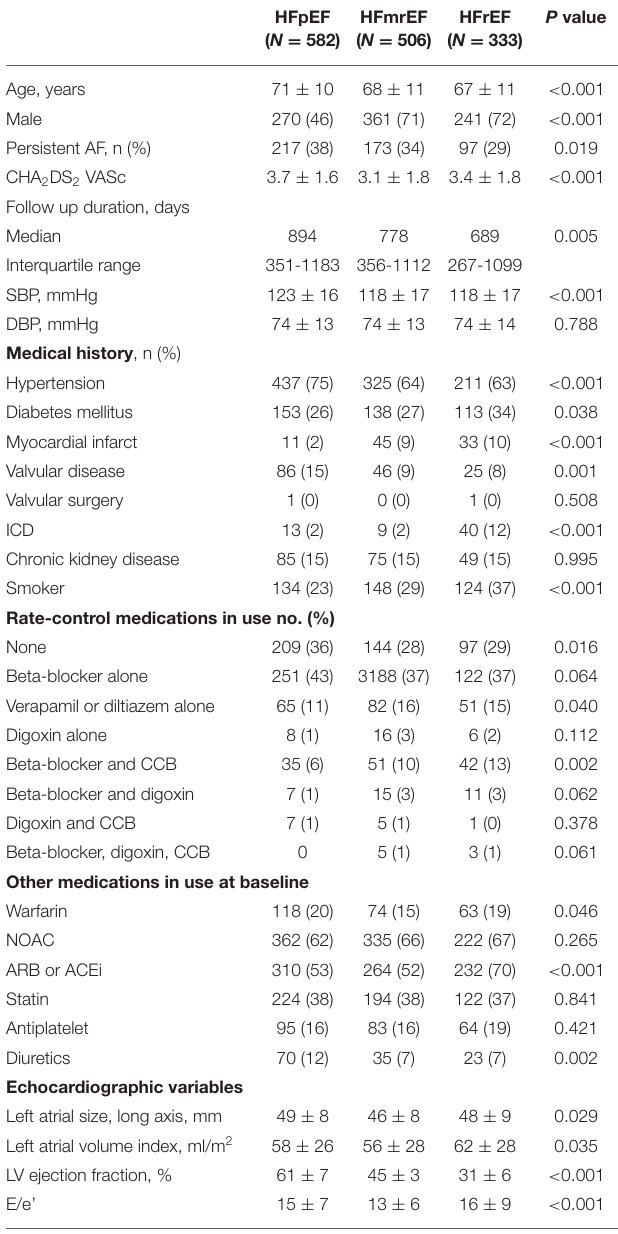
TABLE 1 | Baseline characteristics based on the ejection